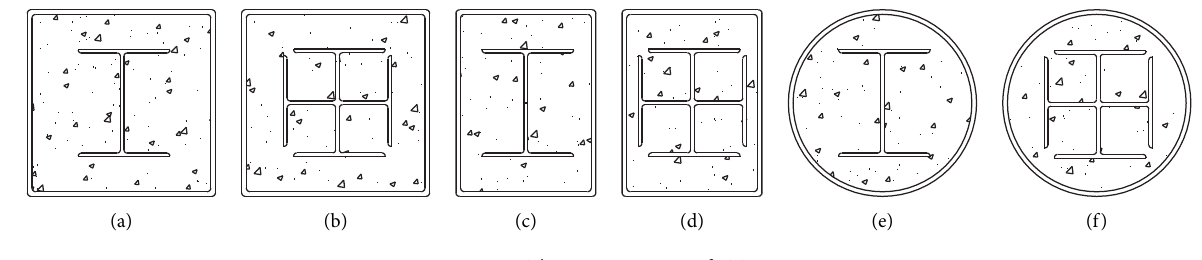
Figure 1: The section types of